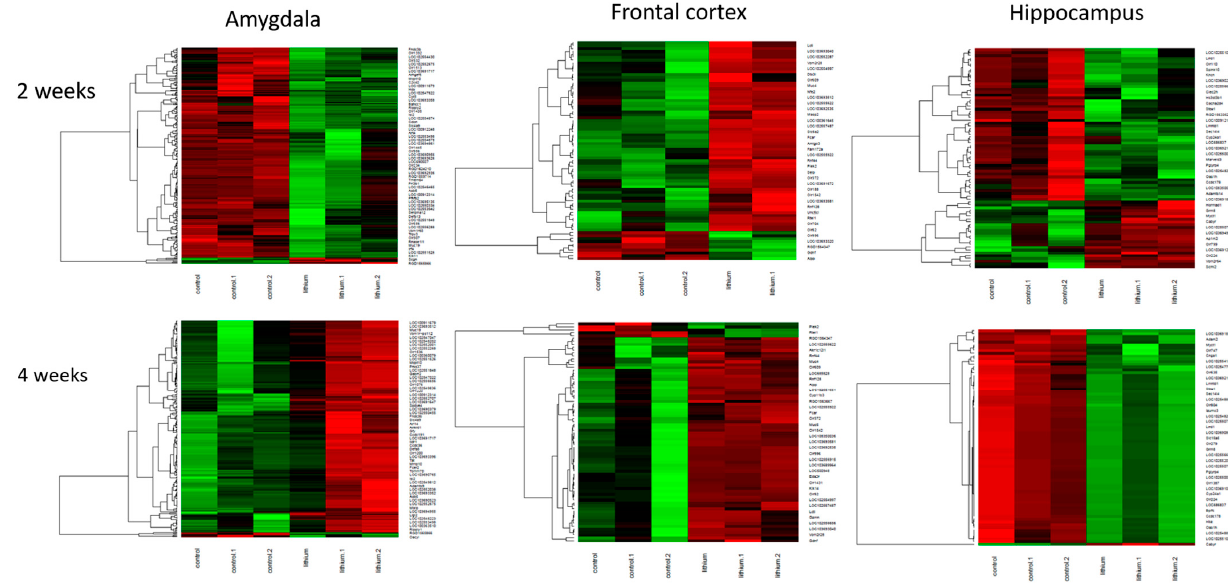
Figure 5. Gene-set enrichment analysis indicated that the genes from olfactory transduction pathway are influenced by chronic lithium administration in manic-like rats in analyzed brain areas (amygdala, frontal cortex and hippocampus).